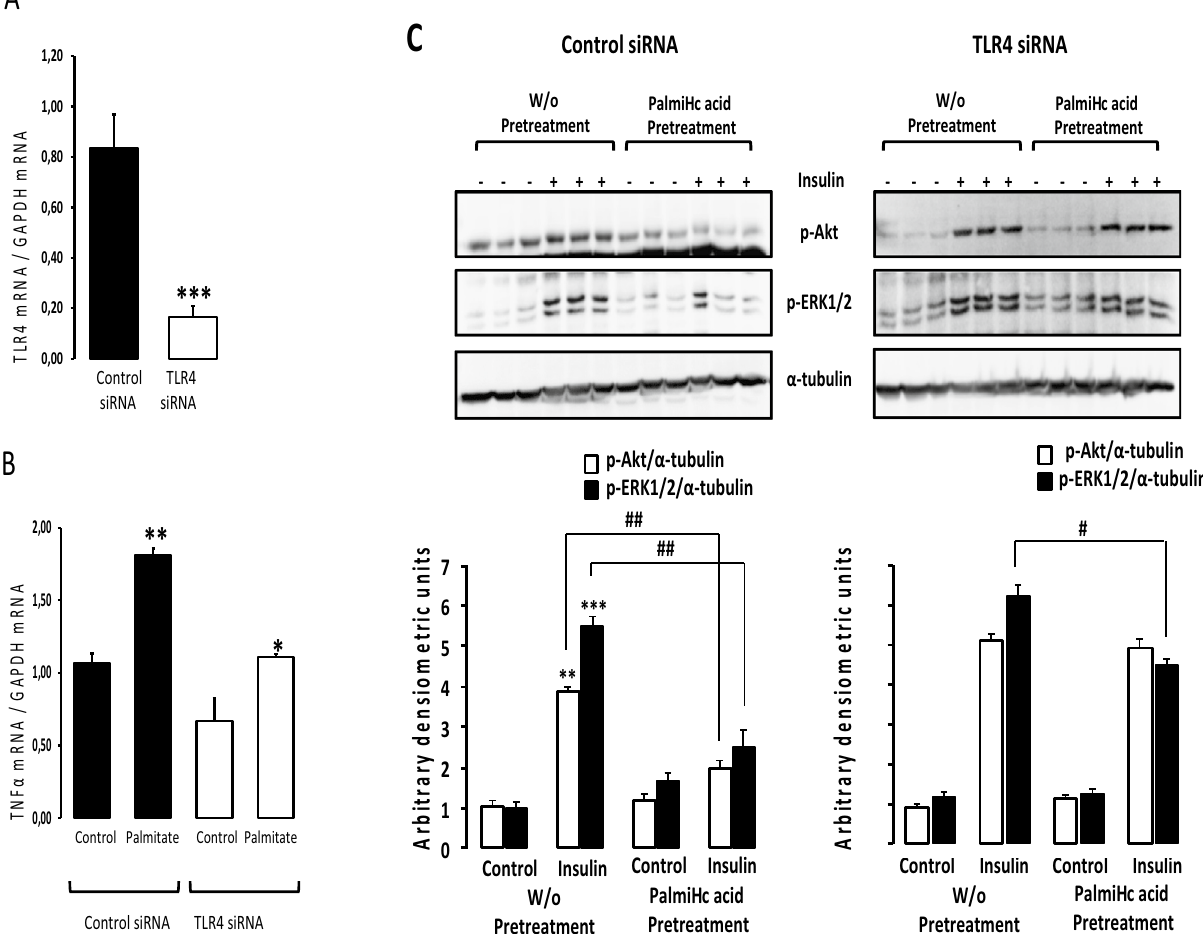
Figure 6. Palmitic acid required TLR4 to partially impair insulin signaling and induced inflammation. (Panel A ) Human SH-SY5Y cells were transiently transfected with siTLR4 or scramble (control siRNA) and then TLR4 expression was measured by RT-qPCR. Data were presented as means ± SEM (n = 3). *** denoted p < 0.001 when comparing control siRNA to TLR4siRNA, statistical analysis was performed using Student t-test. (Panel B ) Human SH-SY5Y cells were transiently transfected with siTLR4 or scramble (control siRNA), cells were cultured in the presence or absence of palmitic acid and then TNFα expression measured by RT-qPCR. Data were presented as means ± SEM (n = 3). * and ** denoted p < 0.05 and p < 0.01, respectively, when comparing control vs palmitate for both cells exposed to control or palmitate condition, statistical analysis was performed using Student t-test. (Panel C ) Human SH-SY5Y cells transfected with control siRNA (scramble) or siTLR4 were preatreated with or without palmitic acid during 4 h then acutely stimulated by insulin. The upper part of panel C shows representative Western blots using anti-pAkt, anti-p-ERK1/2 or anti-αTubilin antibodies and each antibody was used in different membranes. The lower part of panel C shows band density quantification. Phosphorylated Akt and Erk1/2 were normalized to αTubilin. Data were presented as means ± SEM (n = 3). # and ## denoted significant differences at p < 0.05 and p < 0.01, respectively when comparing insulin-dependent phosphorylation of Akt and Erk1/2 between W/O pretreatment and palmitate treatment groups, statistical analysis was performed using Kruskal Wallis test and post-hoc Pairwise comparison in R. ** and *** denoted significant differences at p < 0.05, p < 0.1 and p < 0.001 when comparing Control vs Insulin, statistical analysis was performed using Student